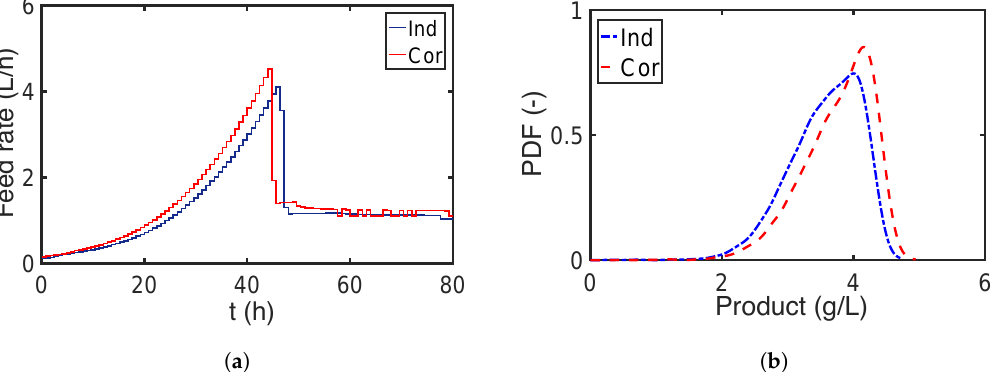
Figure 18. Results for the robust design of the fed-batch bioreactor, where the uncertain parameters are either independent or correlated. ( a ) control sequence for substrate feeding; and ( b ) final concentration of the product, respectively. Table 4. The number of constraint violations from 10,000 Monte Carlo simulations, where the tolerance factor ε nq = 1% and ε nq = 0.14% for both designs with independent and correlated parameters. The performance indicates the mean value of the production concentration at the